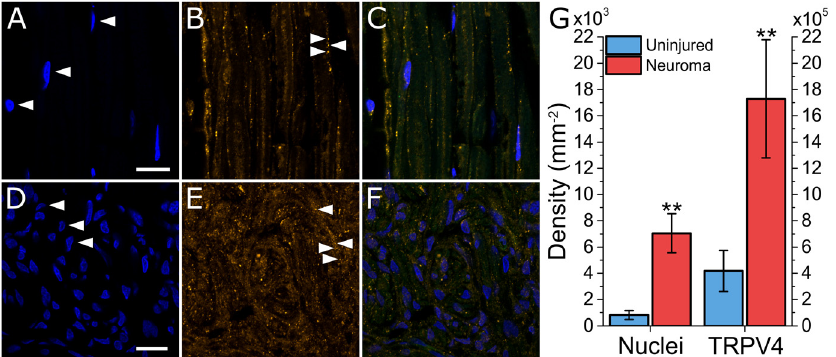
Fig 4. Increased expression of TRPV4 channels and recruitment of non-neuronal cells in 8-week-old amputation neuroma. Representative confocal images (60x with 2x scan zoom) of DAPI-stained cell nuclei ((A, D), blue) and TRPV4 channels ((B, E), gold) in uninjured tibial nerve tissue and within the neuroma bulb, respectively. Scale bar represents 15 μ m. (G) Mean density of nuclei and TRPV4 channels (puncta) in uninjured tibial and neuroma tissues (n = 12). Density comparisons were made by 2 sample t-test ( ** p <